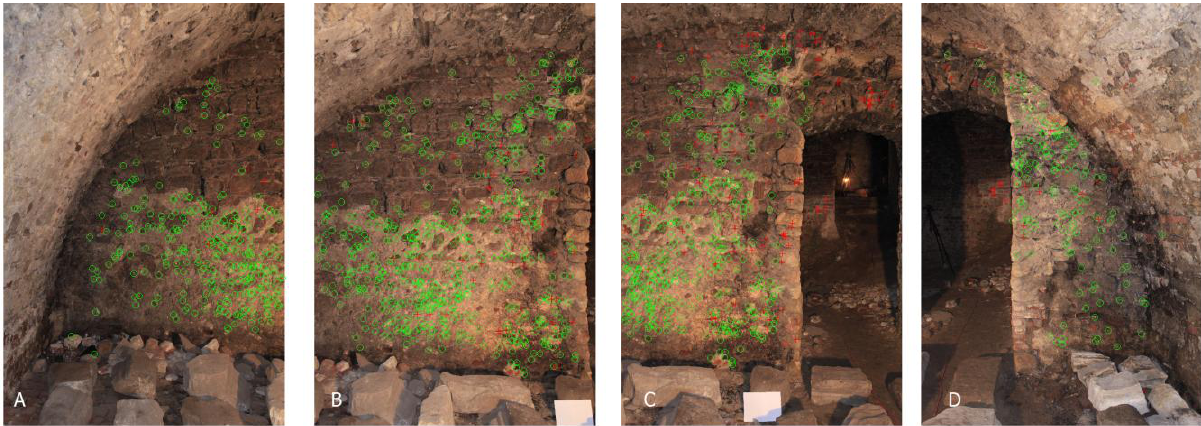
Fig. 13 Utilised photographs with points used for orientation (in green) and points deleted from the process of adjustment (in red)